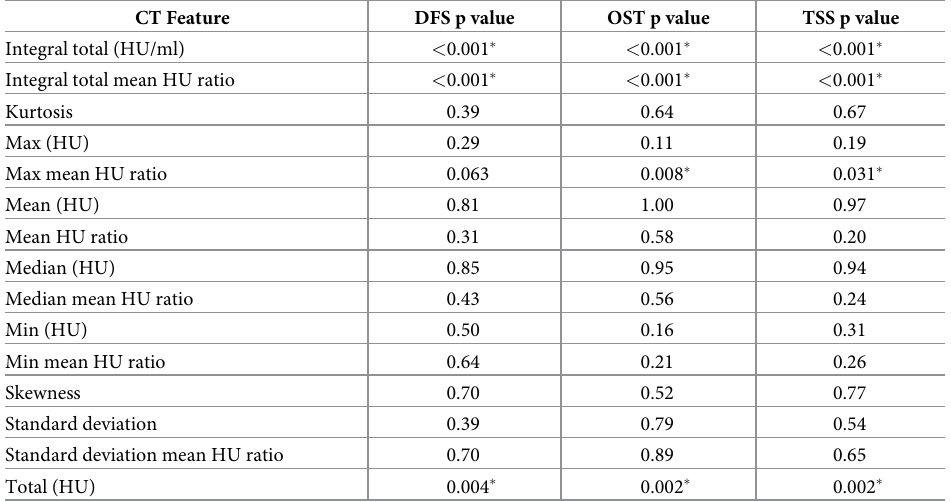
Table 9. Analysis of CT features associated with outcome measures in dogs with lung